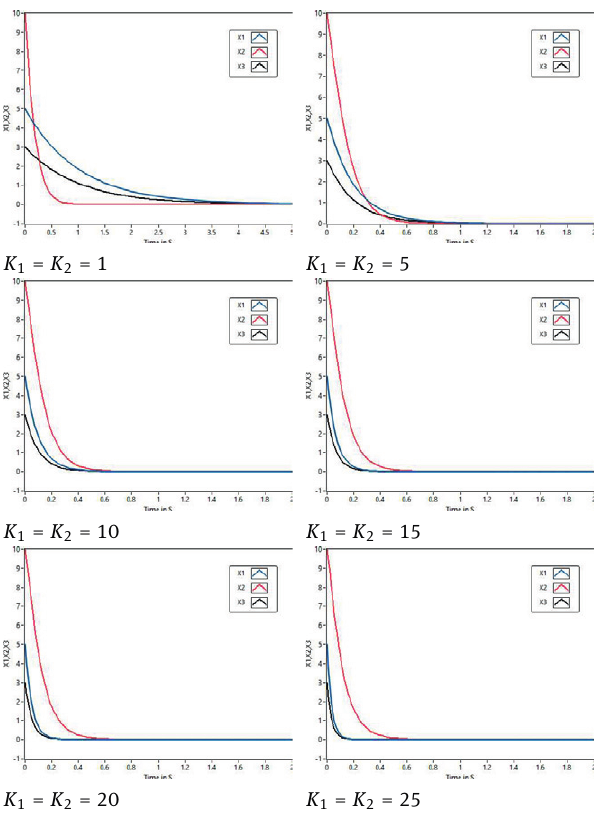
Fig. 4: Effect of Controller gain on Chaos suppression